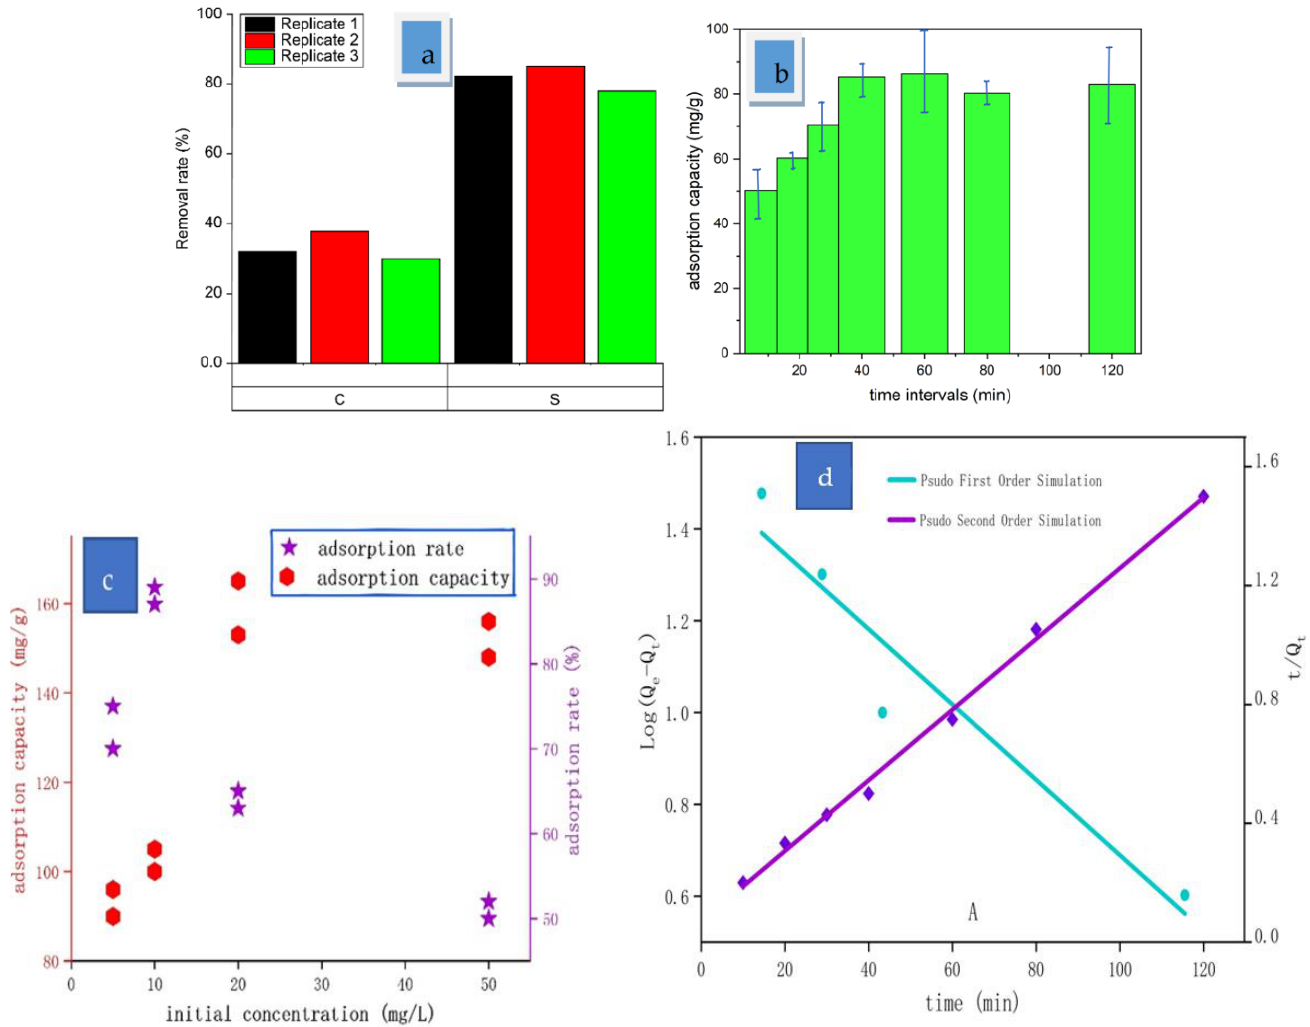
Figure 4. Comparison of adsorption completion after 1 h between sponge only (C) and sponge–La (S) (three replicates each) ( a ); adsorption capacity vs. time intervals for sponge–La ( b ); adsorption capacity and rate vs. initial concentration of phosphate for sponge–La ( c ); kinetic study of sponge–La ( d ).